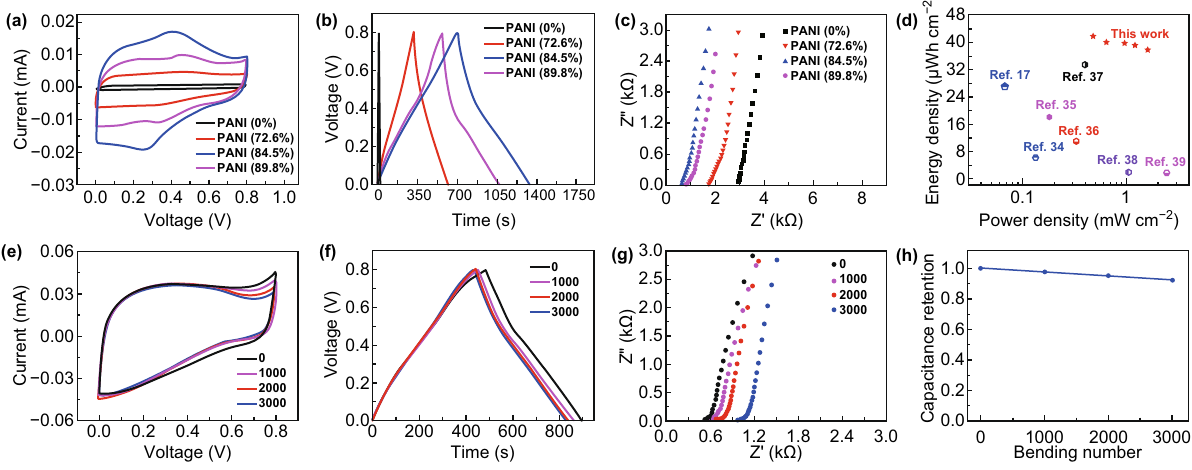
Fig. 3 Electrochemical performance of supercapacitors based on G/CNTs and G/CNTs/PANI hollow fibers. a–c CV curves (scan rate of 10 mV s −1 ), GCD curves (current density of 0.6 mA cm −2 ) and Nyquist plots of the supercapacitors based on G/CNTs/PANI hollow fibers with different mass loading of PANI. d Comparison of energy density and power density of our supercapacitors with other reported fiber- shaped supercapacitors [17, 34–39]. e–g CV curves (scan rate of 10 mV s −1 ), GCD curves (current density of 1.0 mA cm −2 ) and Nyquist plots (10 −2 -10 5 Hz) of supercapacitor under different bending cycles. h Capacitance retention of the supercapacitor during cyclic bending